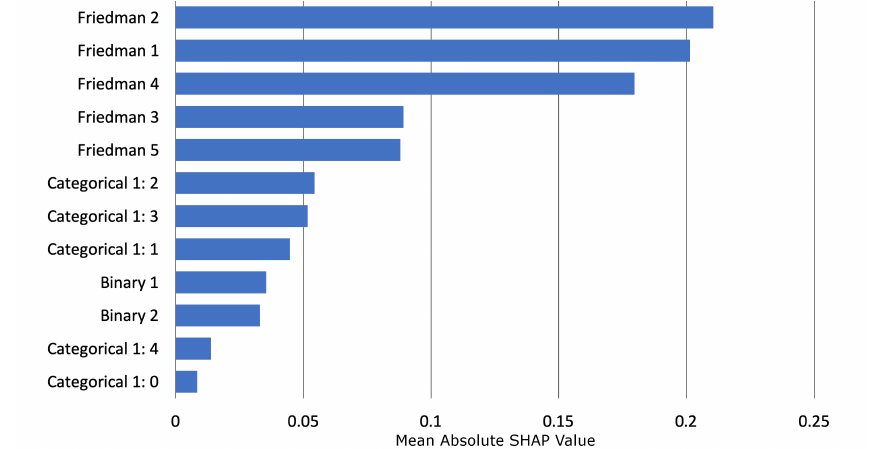
Figure A5. Global mean absolute Deep SHAP feature importance for g XNN ( X ) on the simulated test